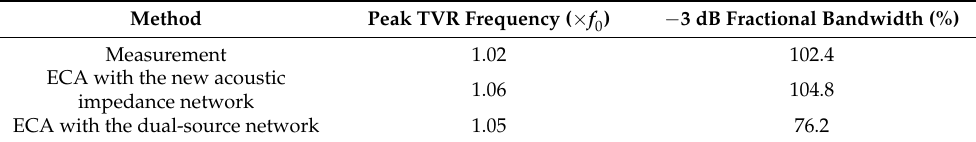
Table 1. Measured and analyzed acoustic characteristics of the cymbal array.